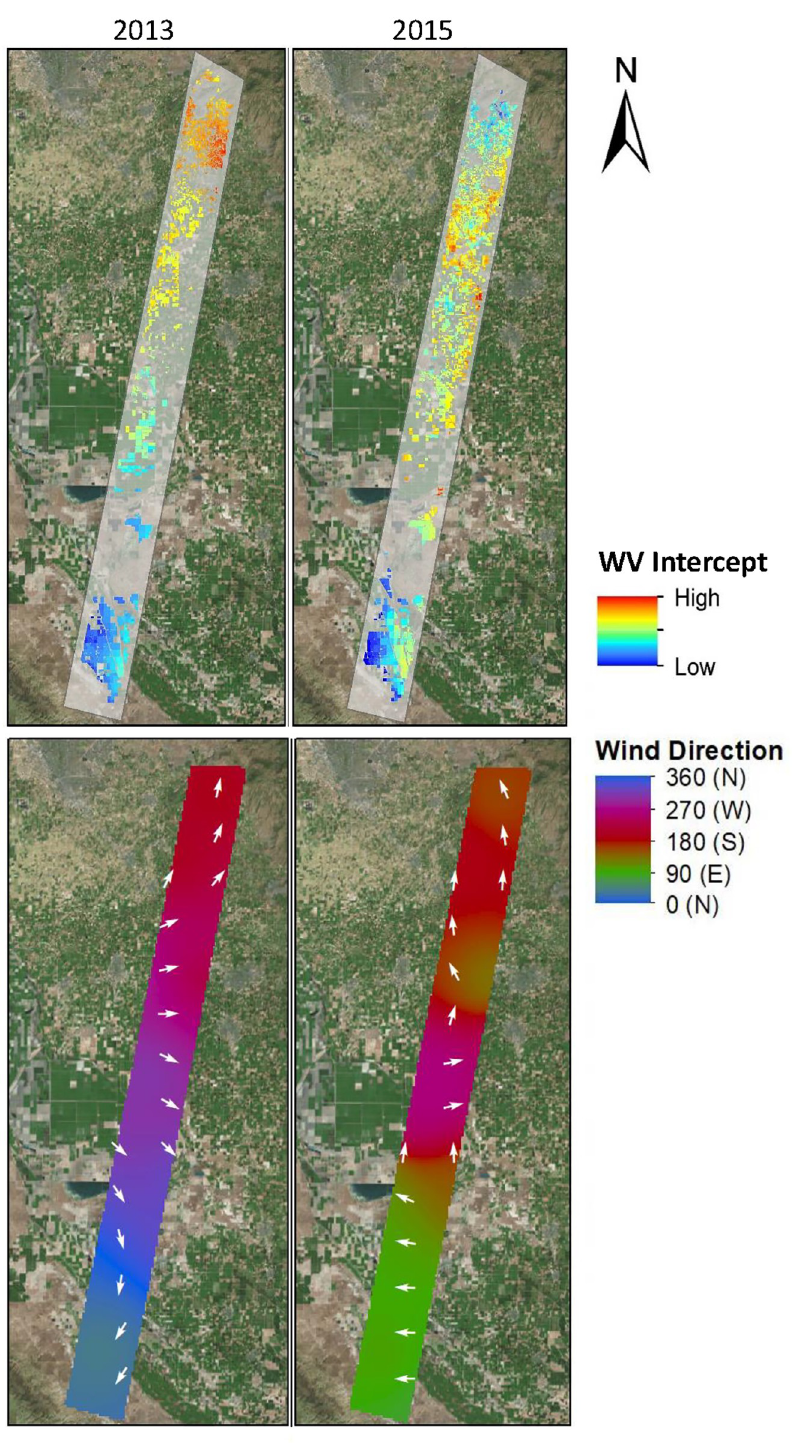
Fig 7. Water vapor intercepts and wind direction maps. Field-level intercepts calculated from water vapor regressions are shown above time-of-flight interpolated wind direction maps for 2013and 2015. Basemap obtained from Esri ArcGIS. Sources: Esri, DigitalGlobe, GeoEye, i-cubed, USDA FSA, USGS, AEX, Getmapping, Aerogrid, IGN, IGP, swisstopo, and the GIS User Community.